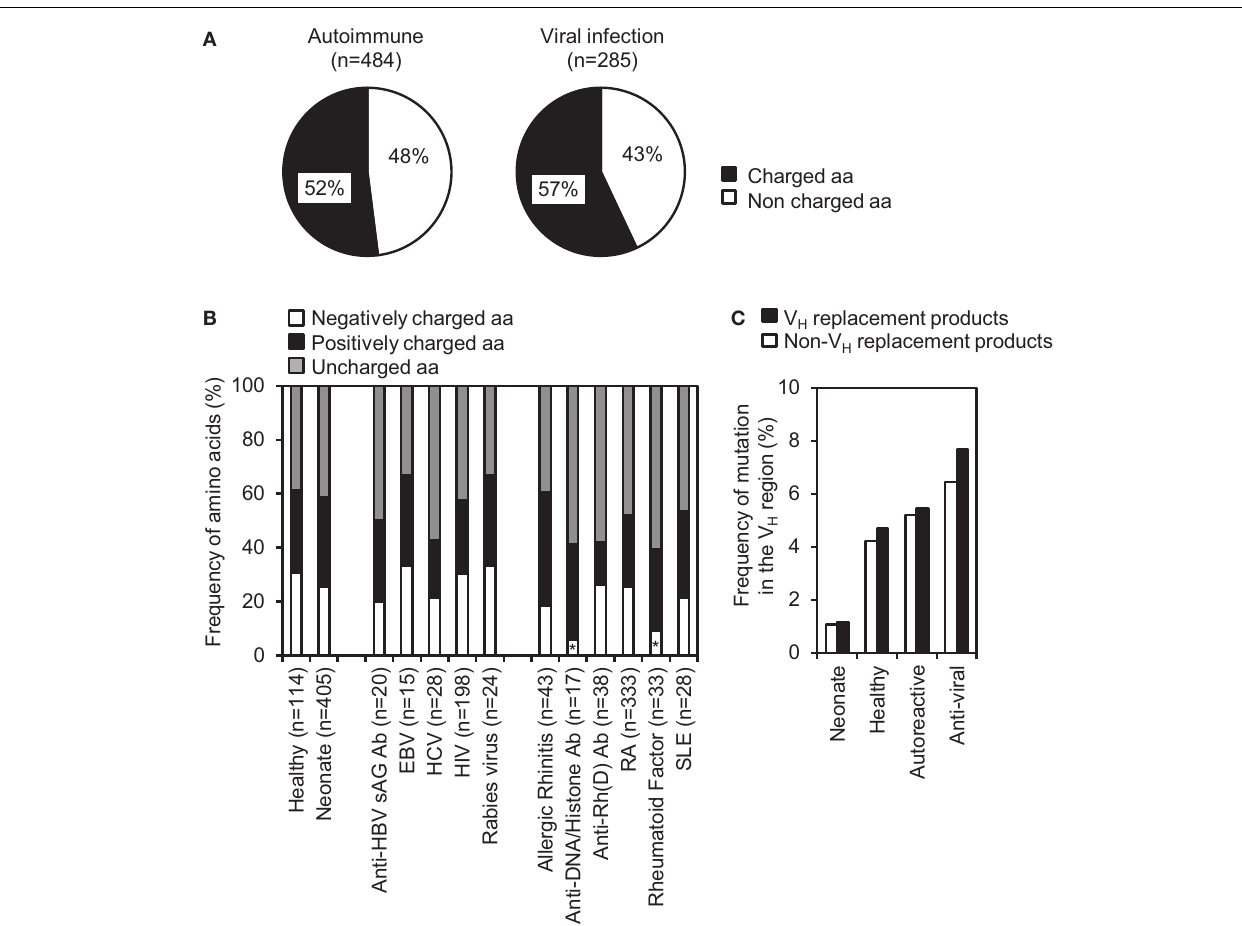
FIGURE 6 |V H replacement footprints preferentially contribute charged amino acids into the CDR3 regions of IgH genes derived from autoimmune diseases and viral infections . (A) Frequencies of charged and uncharged amino acids encoded by theV H replacement footprints in IgH genes derived from autoimmune diseases and viral infections. n ,Total number of amino acids analyzed in each subcategory. (B) Frequencies of negatively